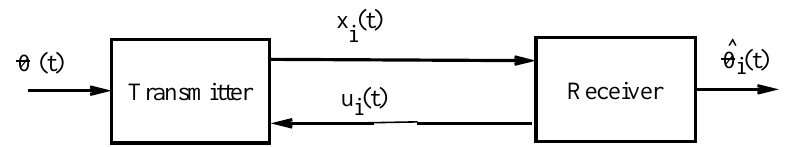
Figure 1. Block diagram of the proposed secure communication